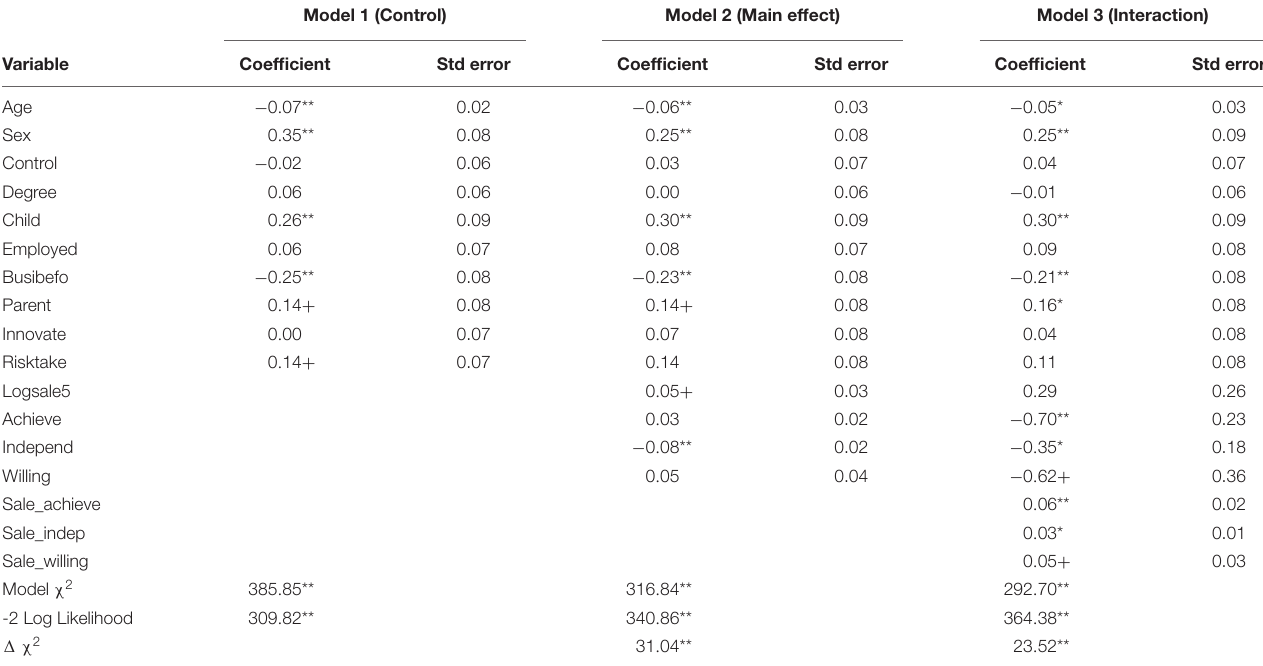
TABLE 1 | Poisson regression results: Motivations and wealth aspiration on number of ideas considered.